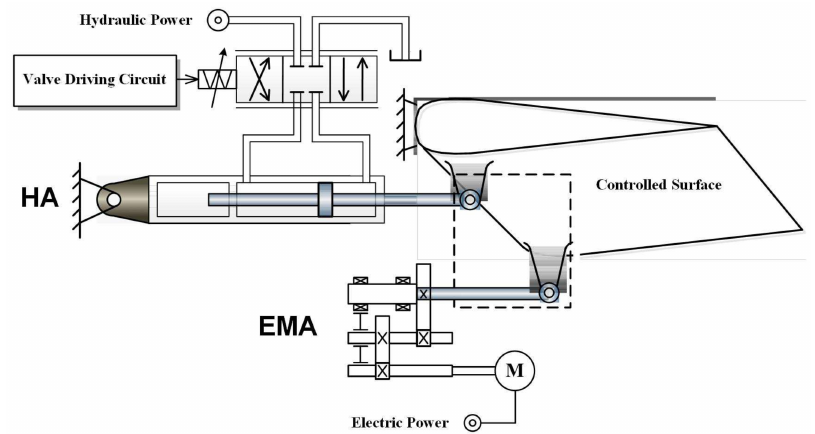
Figure 3. Configuration of actuation system with one HA and one EMA.